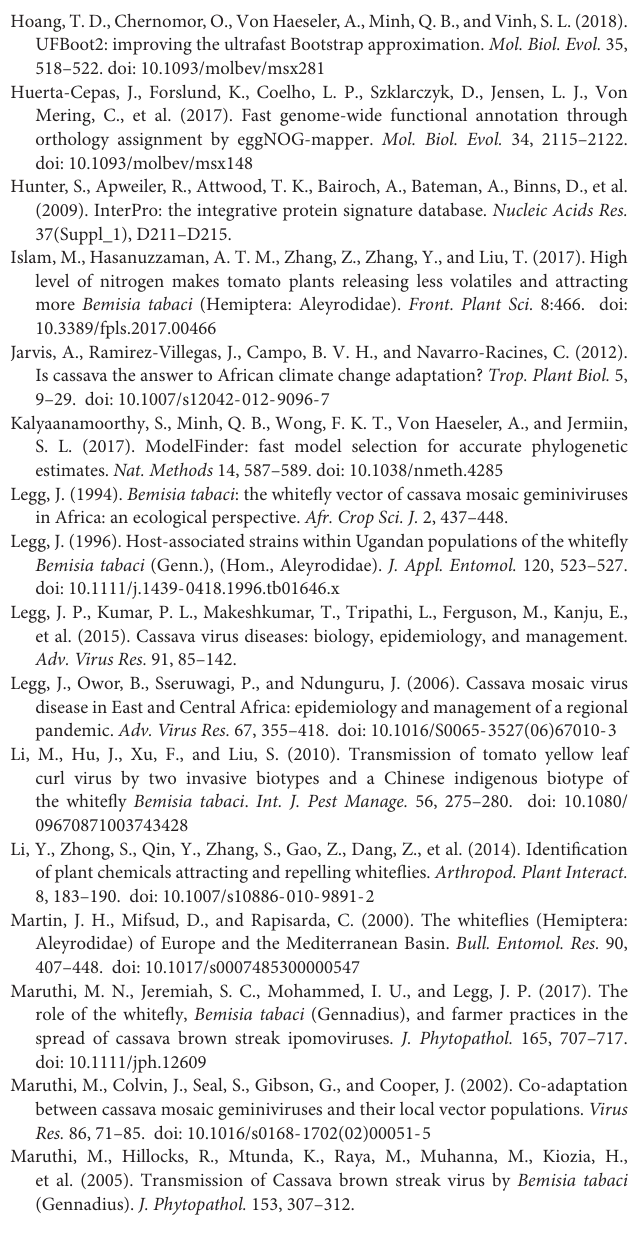
symptomatic cassava plants.